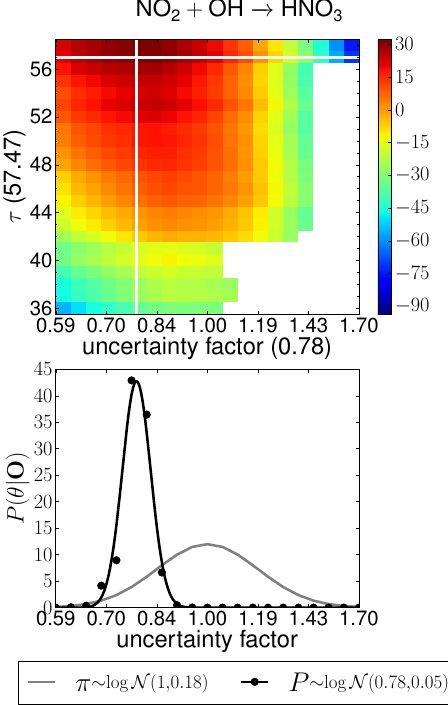
q q +NO → NO 2 +HO reac- Fig. A4. Same as Fig. A1 for the NO 2 +HO 2 Fig. A4. Same as Fig. A1 for the NO 2 +HO . → HNO 3 reaction.